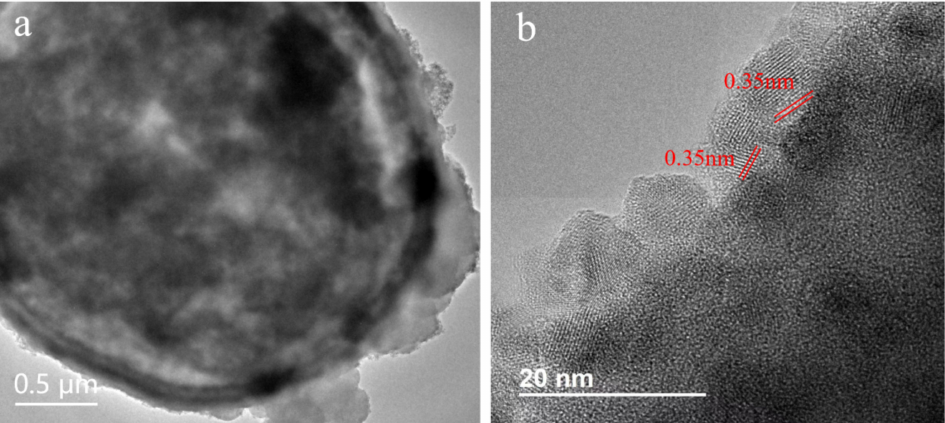
Figure 6. ( a ) TEM image and ( b ) high-resolution TEM image of the TiO 2 -SiO 2